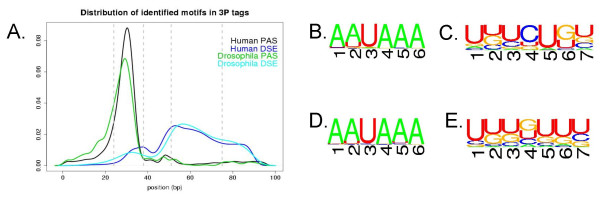
Position and consensus sequence for PAS and DSE identified in Human and Drosophila cleavage site sequence tags (A). Dotted lines: Windows defining the subset of motifs used for the final weight matrix determination, pos 24–38 for PAS and 51–75 for DSE (CS is at position 50). B-E: sequence logos for the inferred weight matrices. B: Human PAS. C: Human DSE. D: Drosophila polyadenylation signal. E: Drosophila DSE.